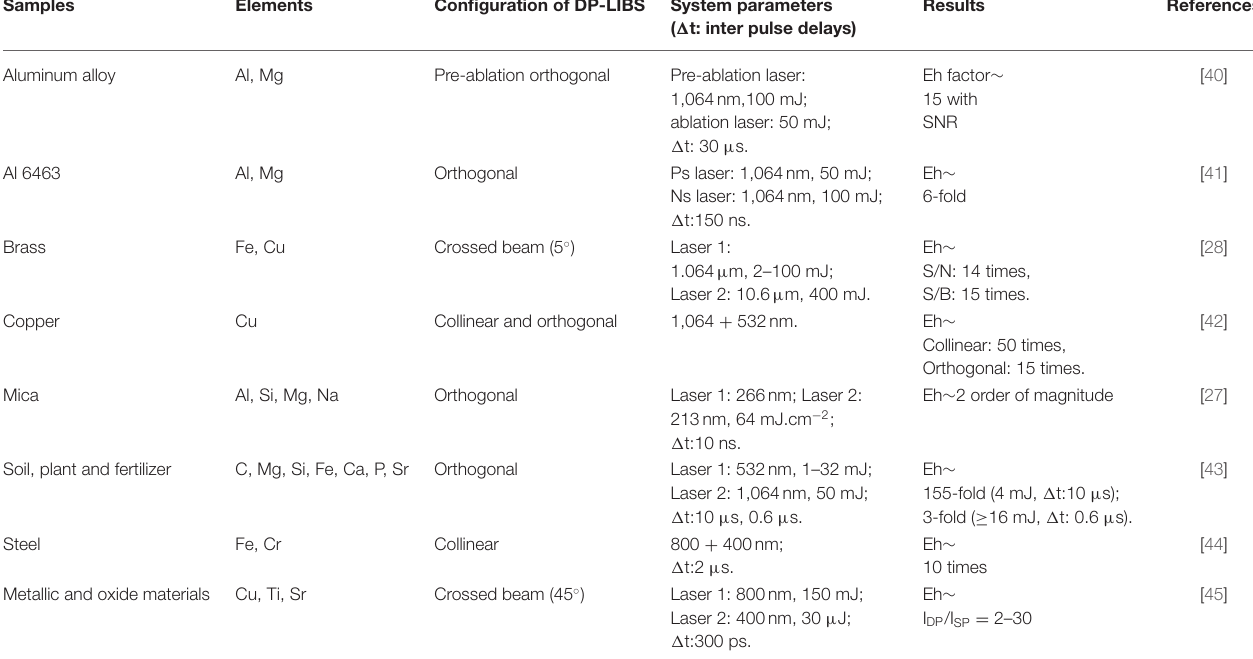
TABLE 1 | The applied examples of DP-LIBS in recent years. Samples